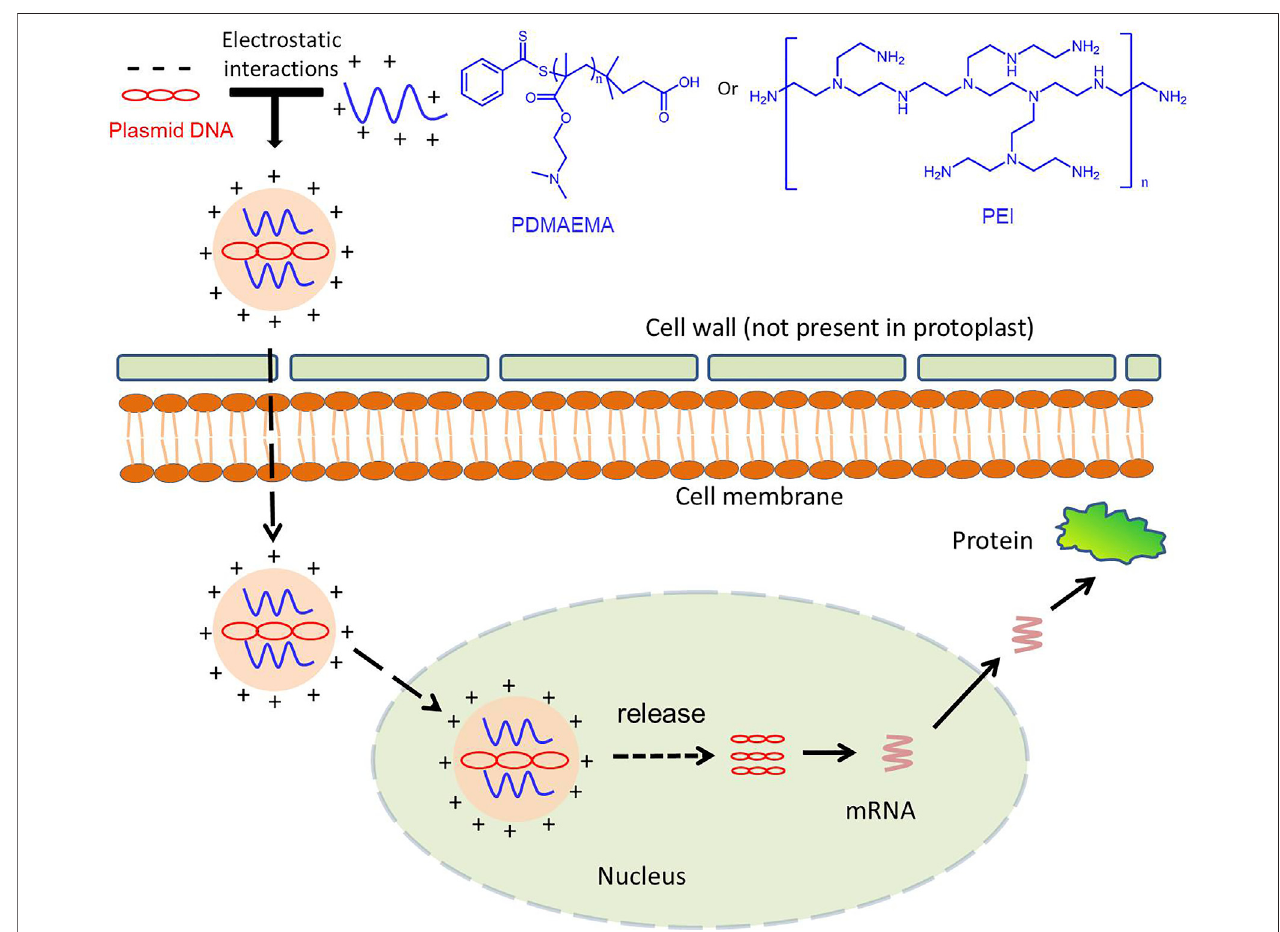
FIGURE 5 | Schematic illustration for the polymer-based gene delivery system in the plant cell.